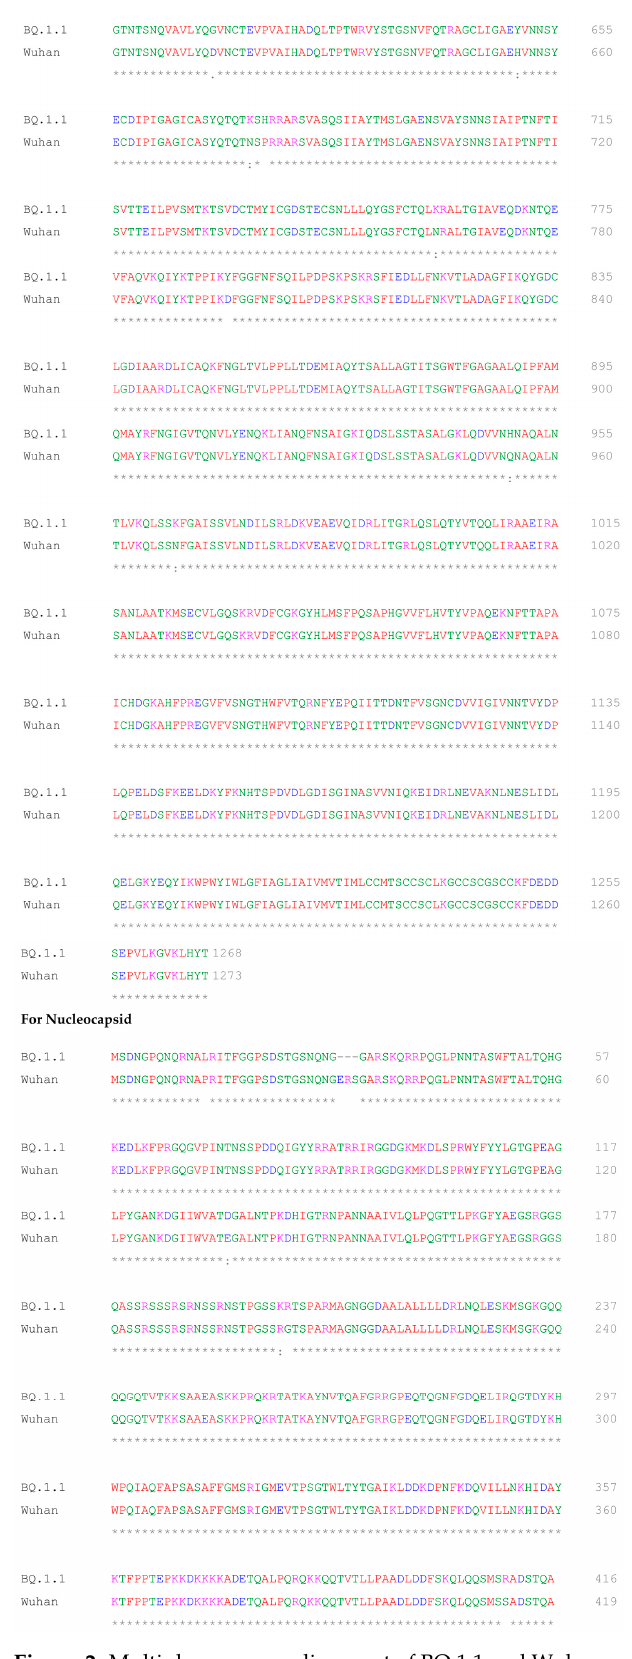
Figure 2. Multiple sequence alignment of BQ.1.1 and Wuhan variant of SARS-CoV-2. Fully conserved residues, insertion/deletion of amino acids, and non-conserved amino acids are indicated by *, ---, and a gap, respectively.